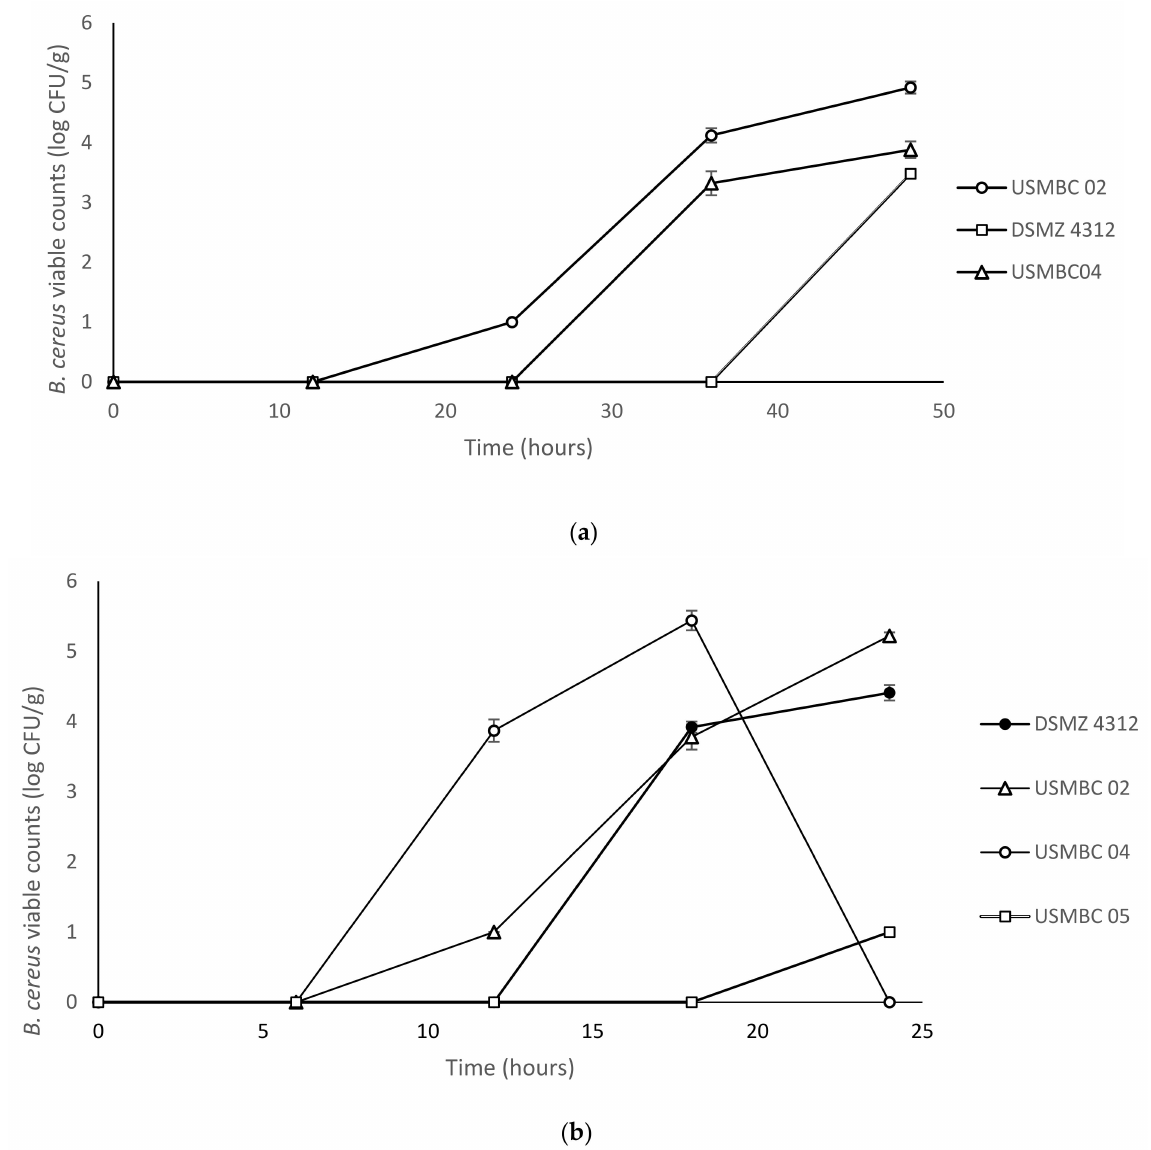
Figure 1. The growth of surviving spores of different B. cereus strains in cooked rice stored at ( a ) 25 ◦ C and ( b ) 30 ◦ C. The absence of B. cereus colony formation in aerobic plate count is represented by zero log CFU/g (below the limit of detection), whereas 1 log CFU/g indicates below the limit of quantification (LOQ). The values represent the means obtained from three independent experiments ± standard